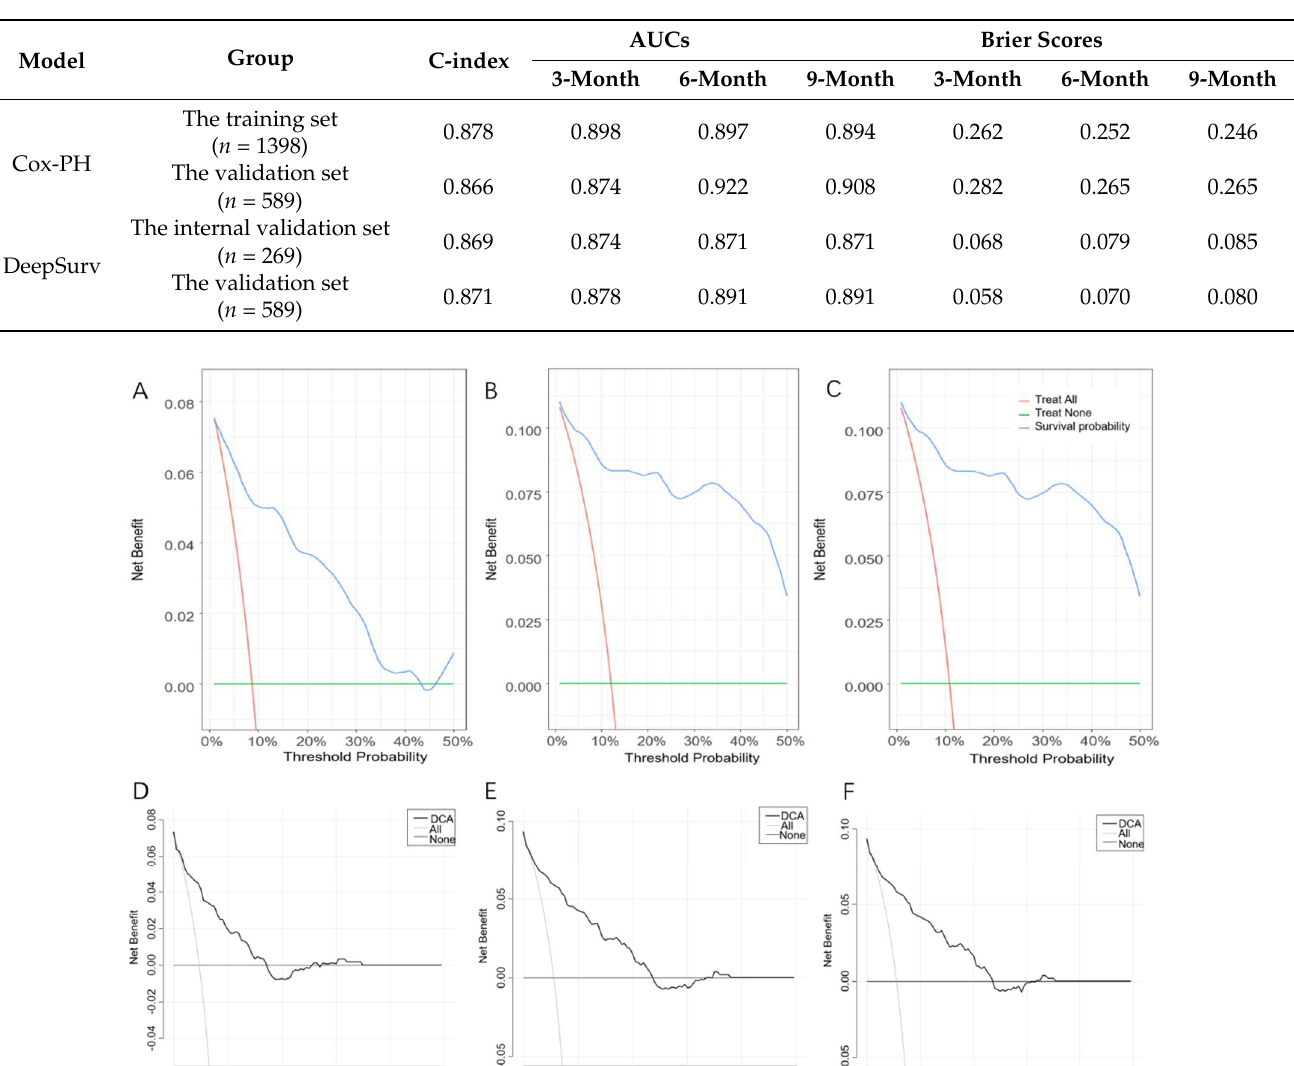
Table 2. Performance of the COX-PH and DeepSurv models.